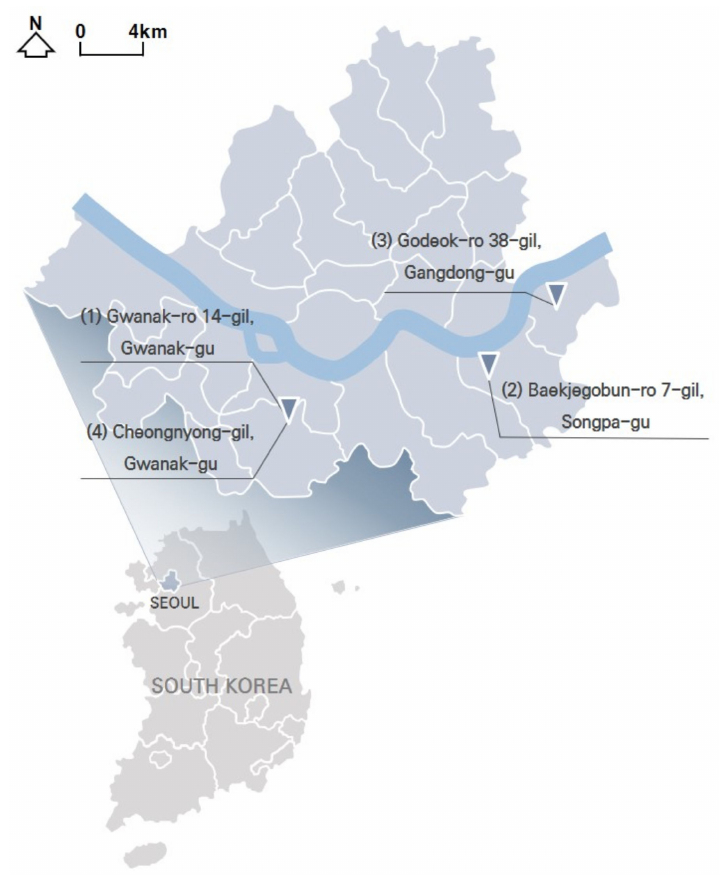
Figure 1. Distribution of the study